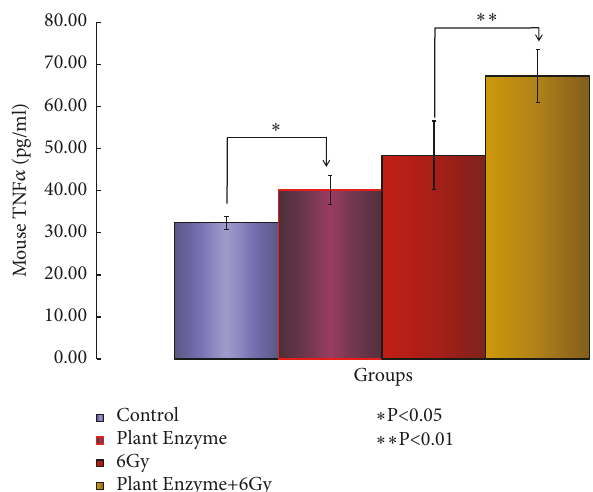
Figure 3: The effects of the Validux Plant Enzyme of repeated administration on the levels of TNF- 𝛼 concentration (pg/mouse) in mice with prostate cancer. Changes in the levels were obtained. The results measured represent ± SD for 7-8 mice. TNF- 𝛼 concentration (pg/mouse) was also measured. ∗ Significantly different from the Validux Plant Enzyme vs. control group ( ∗ P < 0.05 ) and ∗∗ Validux Plant Enzyme +6Gy vs. 6Gy ( ∗∗ P < 0.01 ).